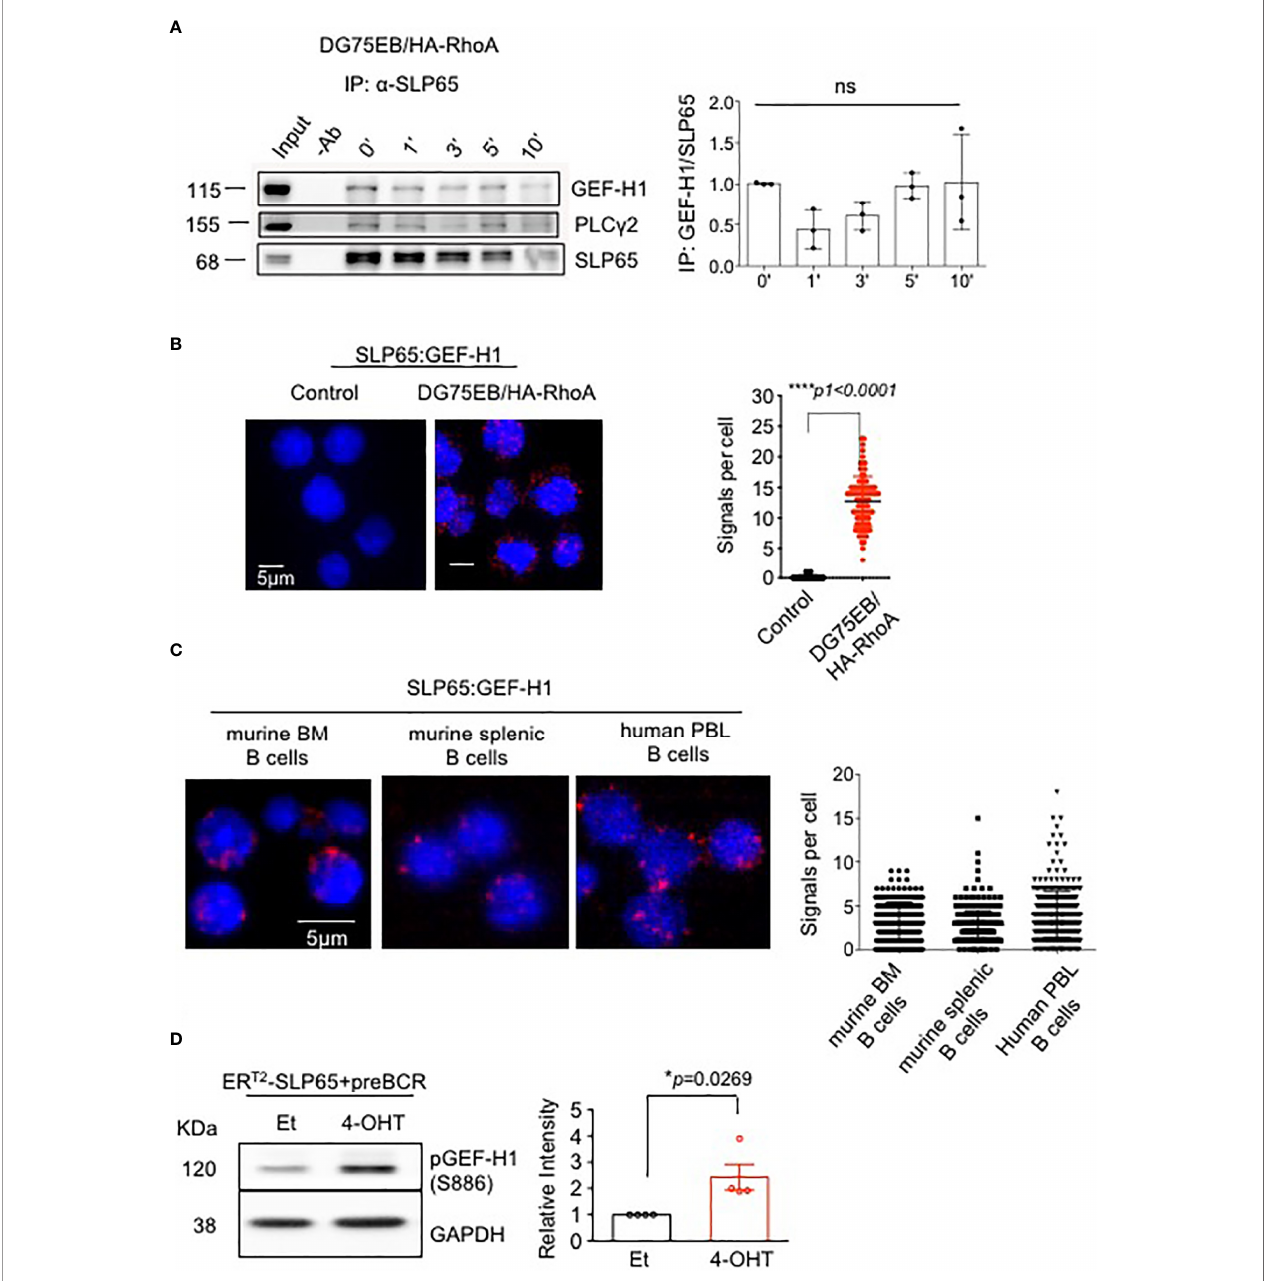
FIGURE 1 | SLP65 interacts speci fi cally with GEF-H1 and triggers its activation. (A) Left panel- Immunoprecipitation followed by western blot analysis for the interaction of endogenous SLP65 with GEF-H1 in DG75EB/HA-RhoA cells upon BCR stimulation. Cells were stimulated with anti-IgM antibody for the indicated time period and IP was carried out with anti-SLP65 antibody. PLC g 2, a known interactor of SLP65 is used as a positive control. Result representative of 3 independent experiments. Right Panel- Quanti fi cation of immunoprecipitated GEF-H1 with respect to SLP65. Statistical analysis- One-way ANOVA. (B) Left- Proximity ligation assay (PLA) to detect the association of SLP65 and GEF-H1 in unstimulated DG75EB/HA-RhoA cell line. Only secondary antibodies are used in the controls. Close proximity is shown as red dots. Right- quanti fi cation of number of signals per cell, error bars represent mean ± SD. Unpaired t-test, two-tailed. (C) PLA to detect the association of SLP65 and GEF-H1 in murine B cells isolated from bone marrow (BM) and spleen (SP) and human peripheral blood (PBL) B cells. B cells are isolated by CD19 magnetic sorting. Close proximity in a range of 10-40 nm is shown as red dots. Right- quanti fi cation of number of signals per cell, error bars represent mean ± SD. (D) Left- western blot analysis for the detection of phosphorylated GEF-H1 upon SLP65 activation in bone marrow derived early pre-B cells from Rag2 -/- , l 5 -/- , Slp65 -/- triple knock out (TKO) mice. The cells were reconstituted with µ-heavy chain, l 5 and inducible SLP65-ER T2 construct and then induced with 2µM 4-hydroxy tamoxifen (4-OHT) or ethanol (Et) for 30 min to activate SLP65. GAPDH is used as loading control. Right- quanti fi cation of pGEF-H1 band intensity with respect to GAPDH. Result representative of 4 independent experiments. Statistical analysis- unpaired t test, two tailed. *p<0.05, ****p<0.0001, ns, not signi fi